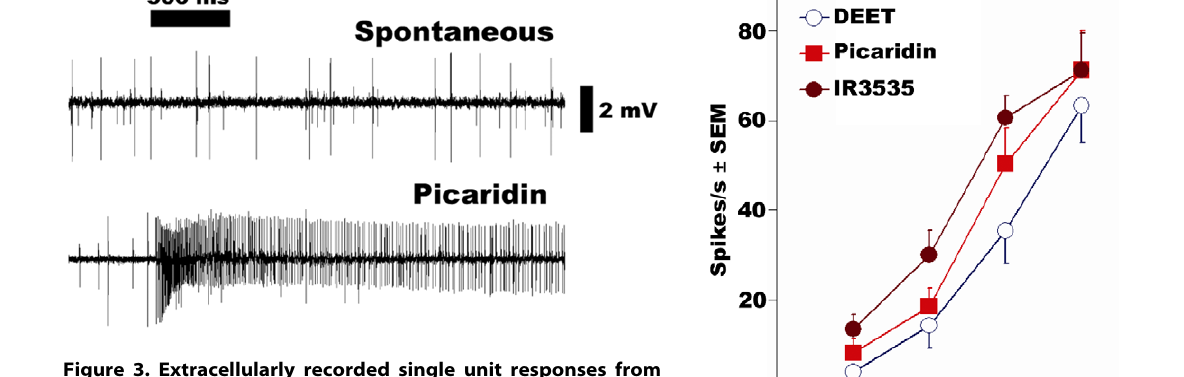
Figure 3. Extracellularly recorded single unit responses from an ab3 sensillum. Spontaneous activity (upper trace) and picaridin- induced excitatory response (lower trace) from the large amplitude neuron, ab3A. Source dose, 100 m g. Note the excitatory responses lasted beyond the stimulus period.